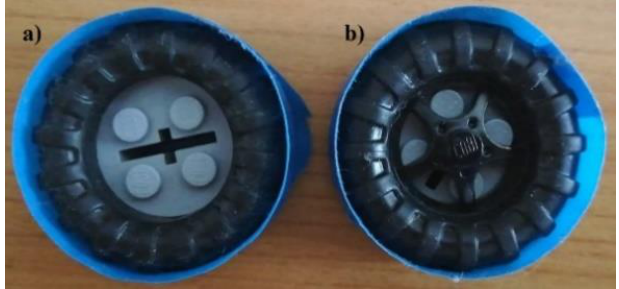
Figure 6. Products for the first task: ( a ) NOK (wheel without spoke), ( b ) OK (wheel with spoke).